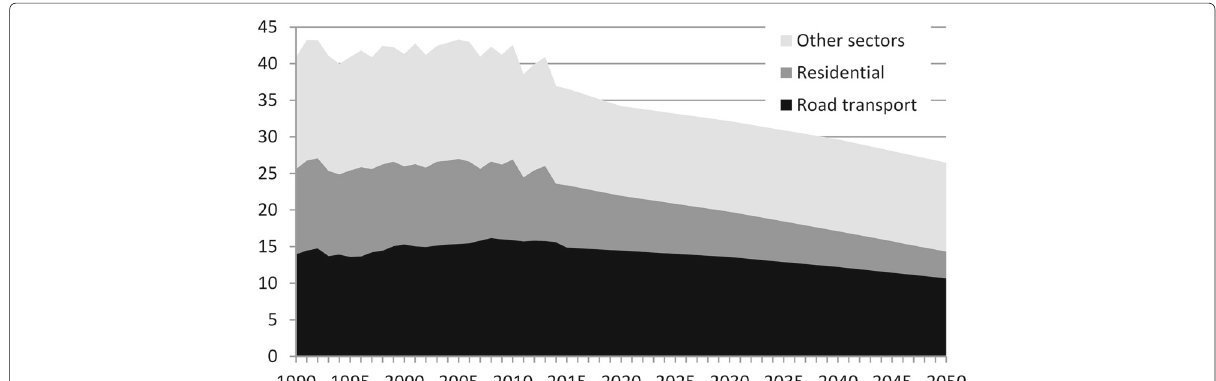
Fig. 2 CO 2 emissions from energy combustion (1A) in the reference scenario in Mt CO 2 (1990–2015: historical